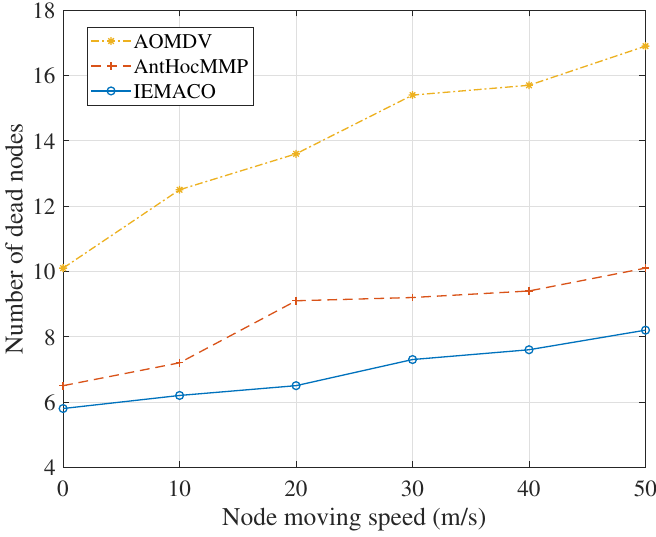
Figure 7. Number of dead nodes versus node moving